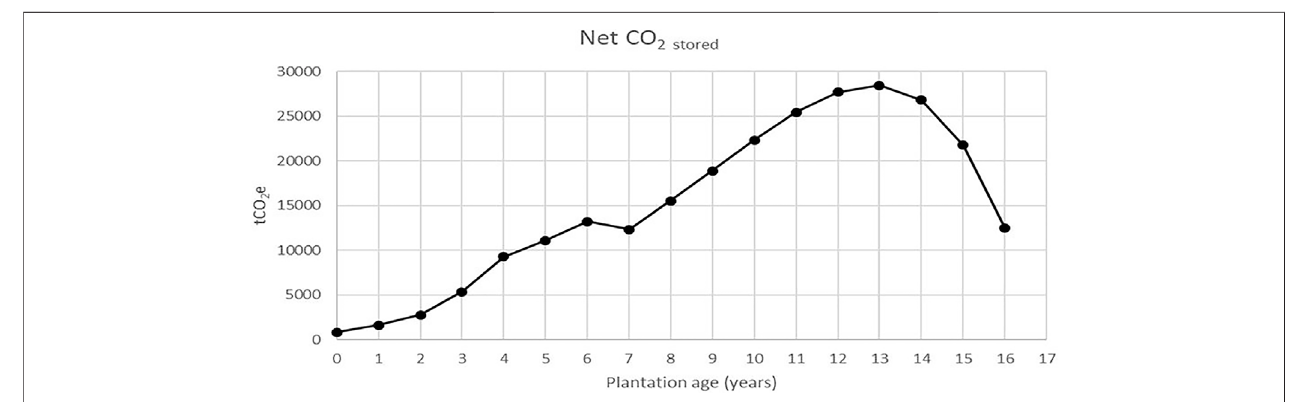
FIGURE 3 | Net carbon dioxide fraction segregated by the entire moso bamboo plantation after subtraction of the aliquot stored in the cut fraction (20% above- ground biomass).